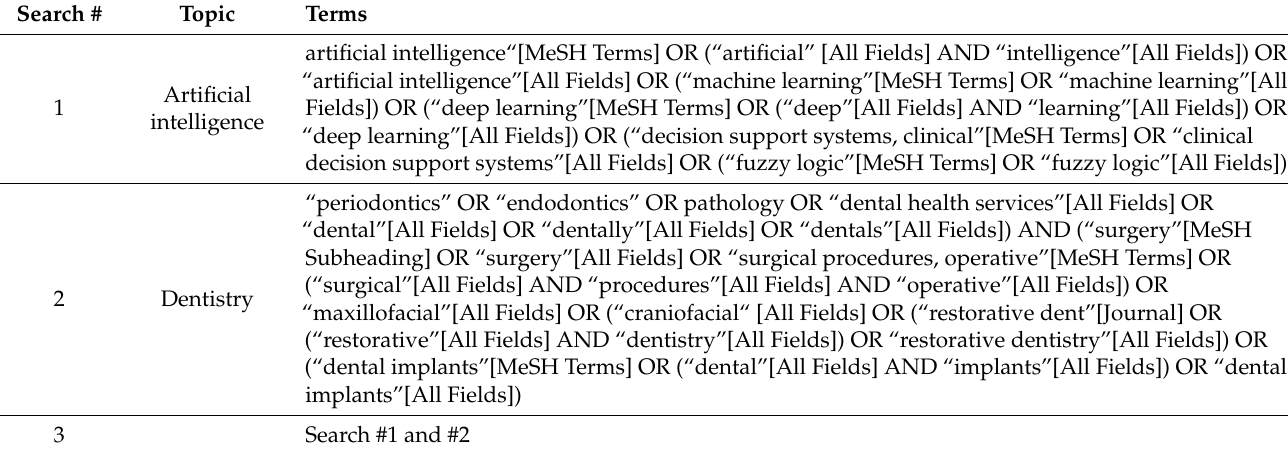
Table 1. Search strategy conducted in different